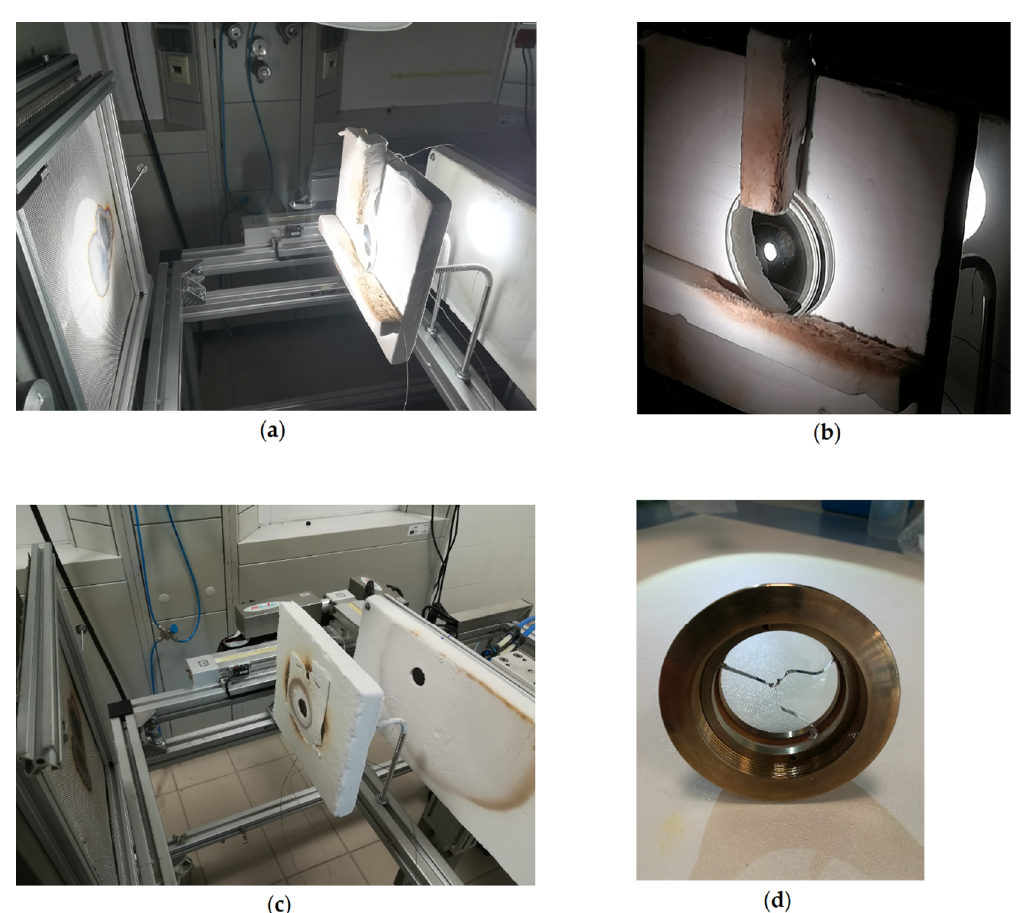
Figure 5. Details of experimental setup for the irradiation tests using xenon arc lamp projector. ( a ) Photo of an irradiation test showing a metallic grid used as radiation attenuator (at the left) and irradiated lens (at the right); ( b ) lens (of 76.2 mm diameter) being irradiated, simply surrounded by alumina foam; ( c ) for confining the radiation beam, in some tests we have used a mask made of alumina felt with a circular aperture of 1 inch (25.4 mm) diameter; the Gardon-type radiometer is on the right protected by alumina foam; ( d ) fractured lens (of 50.8 mm diameter) mounted in metallic holder.